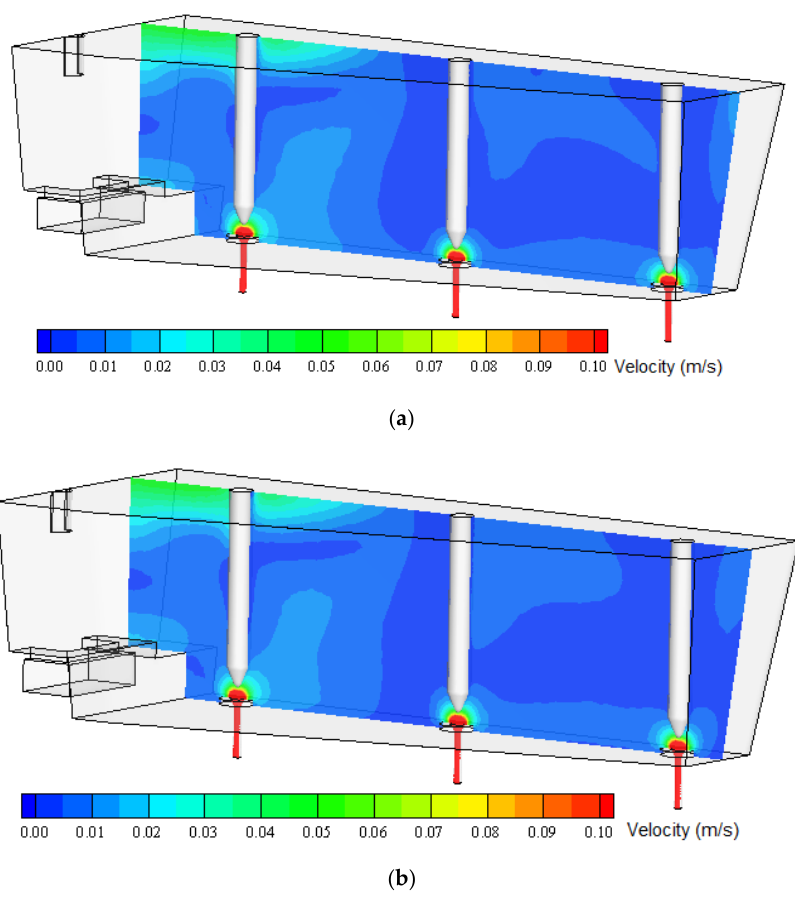
Figure 14. Numerically predicted velocity field of liquid steel in the longitudinal tundish plane passing through submerged entry nozzles (SENs): ( a ) base viscosity, ( b ) experimentally obtained viscosity.